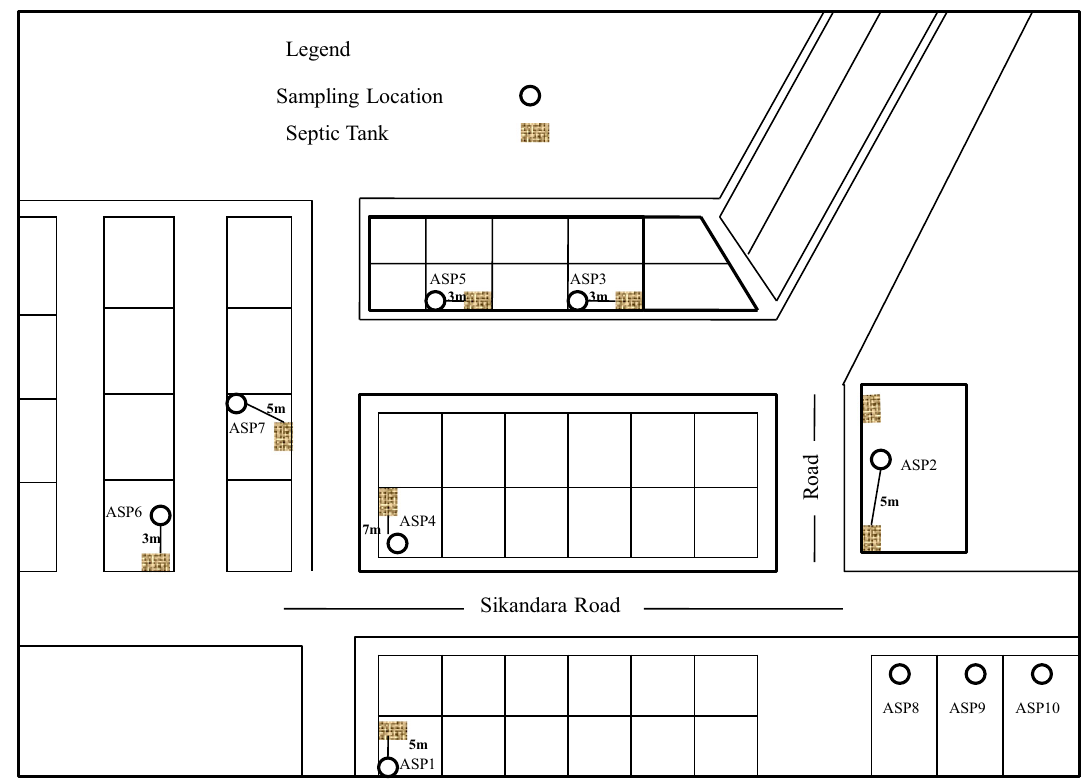
Fig. 4 Schematic map (not to scale) of sampling locations in Laxmi Nagar, Agra Fig. 5 TDS concentration in samples BIS limit (2000 mg/L) collected from Pandav